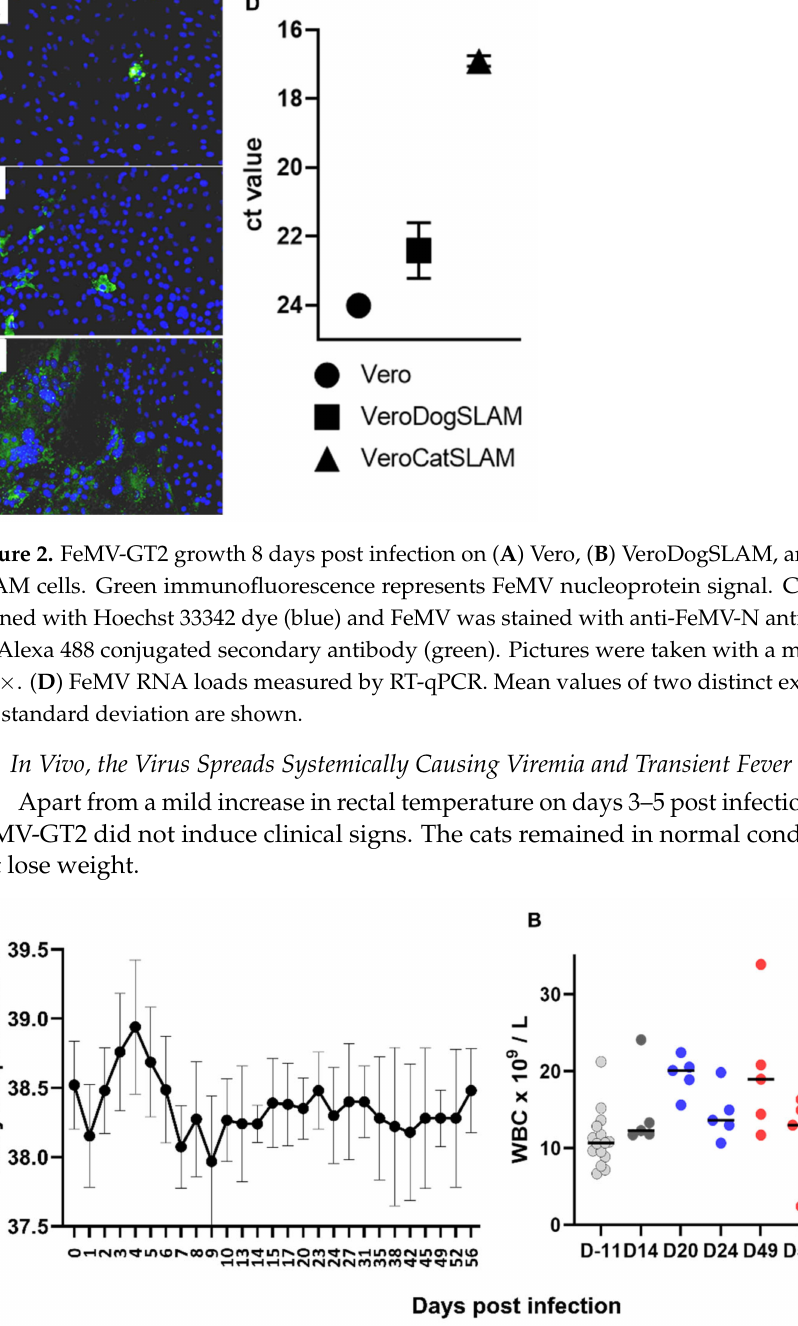
Figure 3. Clinical pathology parameters. ( A ) Rectal temperatures (mean and SD, number of cats: 5, 10, or 15 depending on time point) in cats after experimental infection with FeMV-GT2 on day 0. ( B ) White blood cell counts in cats after experimental infection with FeMV-GT2 on day 0. Individual values and mean values are shown as lines. Point colors refer to the groups and their associated sampling times (Table 1): light grey = all cats, dark grey = group A, blue = group B, red = group C. A transient and mild increase in WBC counts above normal range (5500–19,500/ µ L) was observed between days 20 and 49 (Figure 3B). Other blood cell counts (red blood cells and platelets) remain normal along the observation